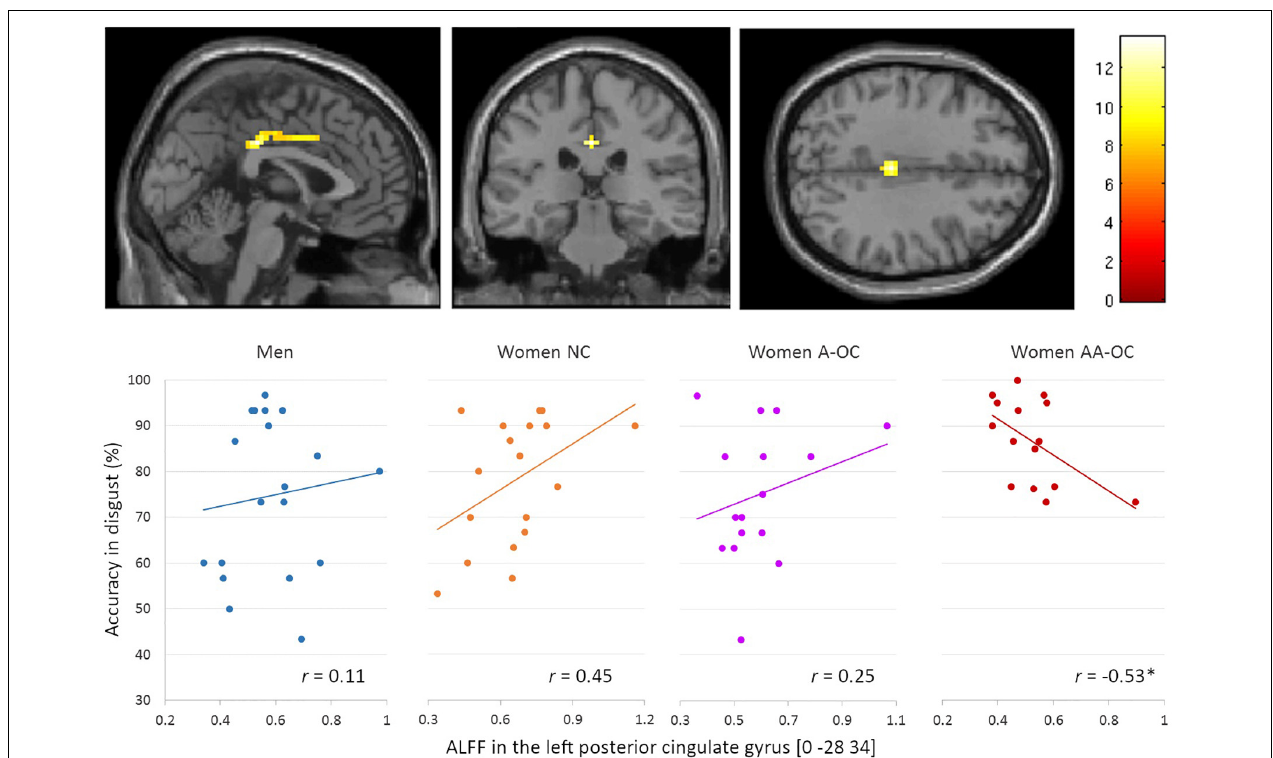
FIGURE 3 | Relationship between the amplitude of low-frequency fluctuations (ALFF) in the left posterior cingulate gyrus and accuracy for disgust faces by group. ALFF and accuracy were found to be moderately negatively correlated for women on AA-OC. * p <